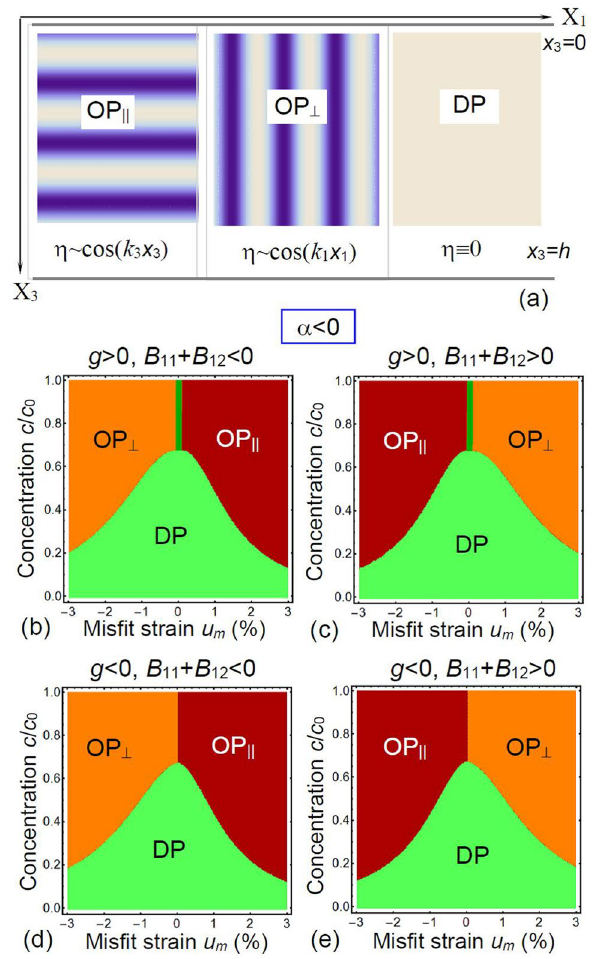
Figure 3. ( a ) Geometry of the problem and schematics of different phases characterized by different directions of the order parameter η modulation. The OP || phase is characterized by a periodic change η ∼ perpendicular to the substrate plane x 3 = h . The OP ⊥ phase is characterized by a periodic change ∼ η cos[k 1 x 1 + δ ] parallel to the substrate plane x 3 = h . The disordered DP phase is characterized by η = 0 . η ∼ (cid:31) (cid:31) ( b )–( e ) Phase diagrams in dependence on the normalized defect concentration c / c 0 and misfit strain u m (cid:31) (cid:31) (cid:31) (cid:31) calculated for negative α, different signs of coefficient g and striction coefficients B ij (indicated above the plots) at room temperature T = 293 K. Parameters: α c 2 0 = − 6 × 10 4 J m −3 , 2 = − 2 × 10 − 26 J ⋅ m 2 , and maximal (steric limit) concentration of defects is c 0 =10 25 m −3 12 c 0